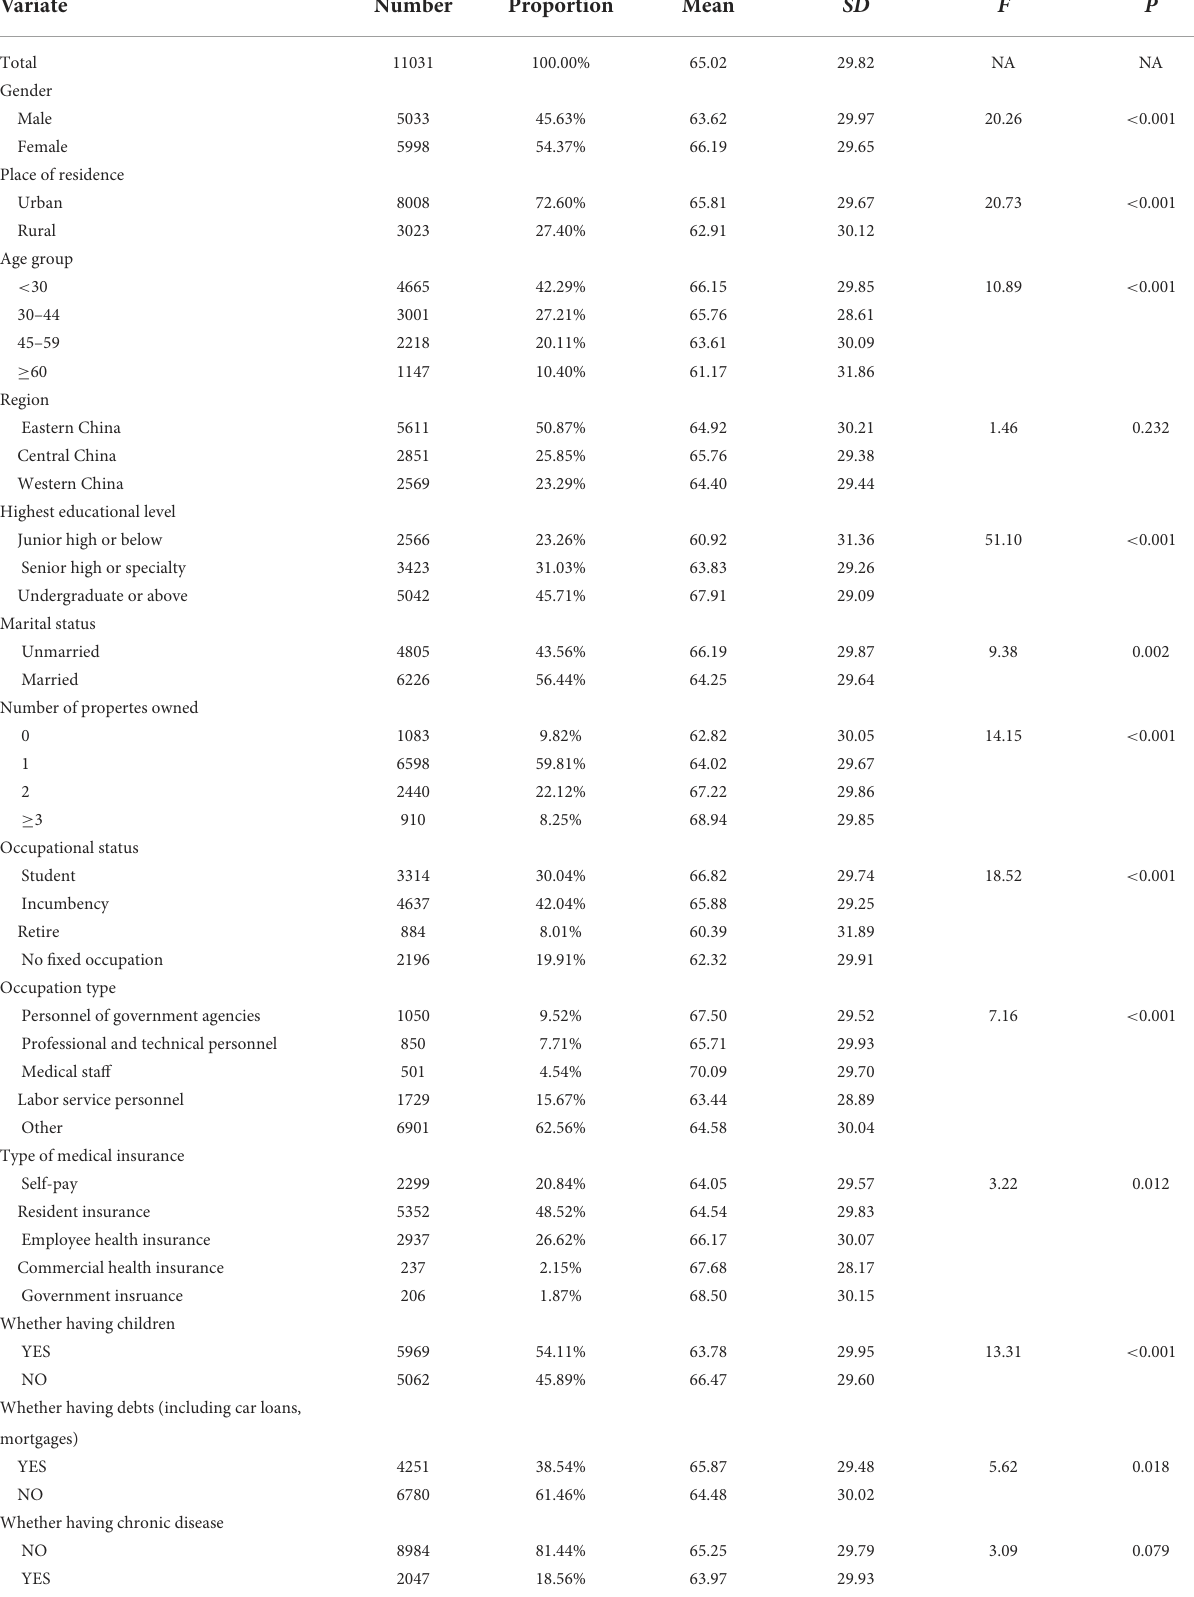
TABLE 1 Descriptive statistics of hospice acceptance among study